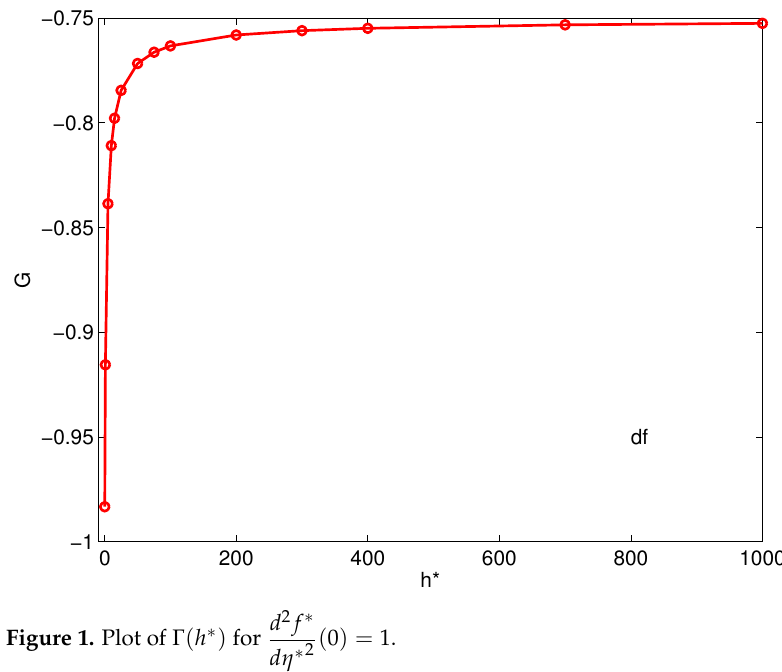
Figure 1. Plot of Γ ( h ∗ ) for